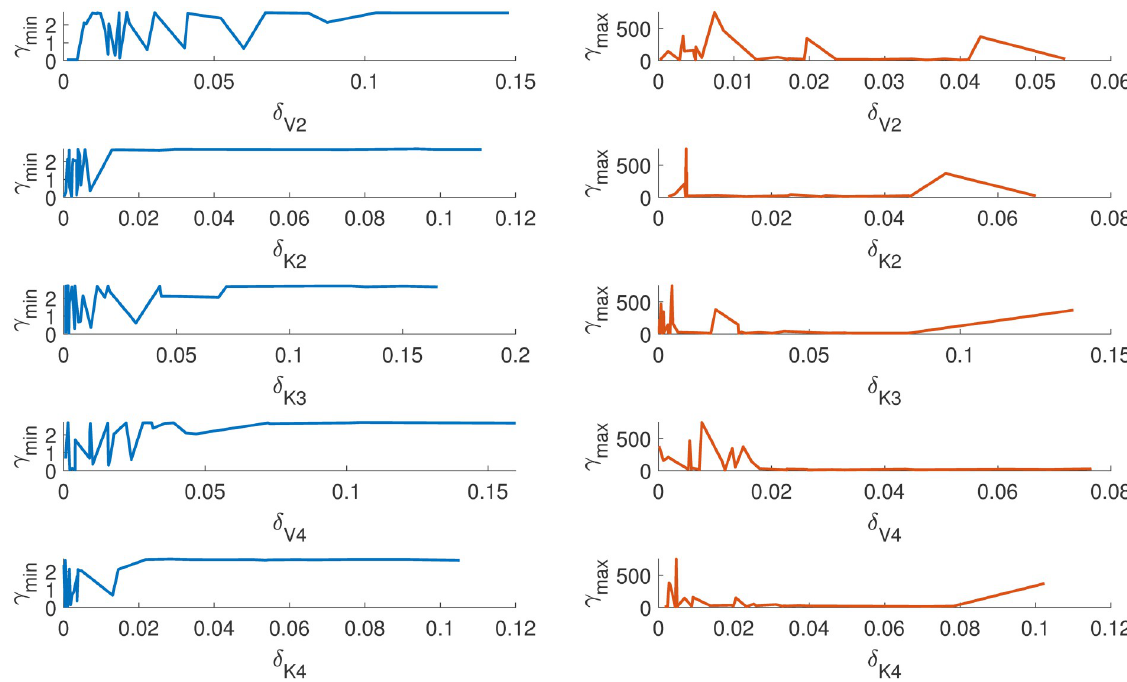
Fig 8. The figure shows how the γ min and γ max changes with respect to the absolute change in each parameters V 2 , K 2 , K 3 , V 4 , K 4 from reference values. The parameters K 4 , V 4 & K 2 are insensitive and contributes to the sloppy direction.